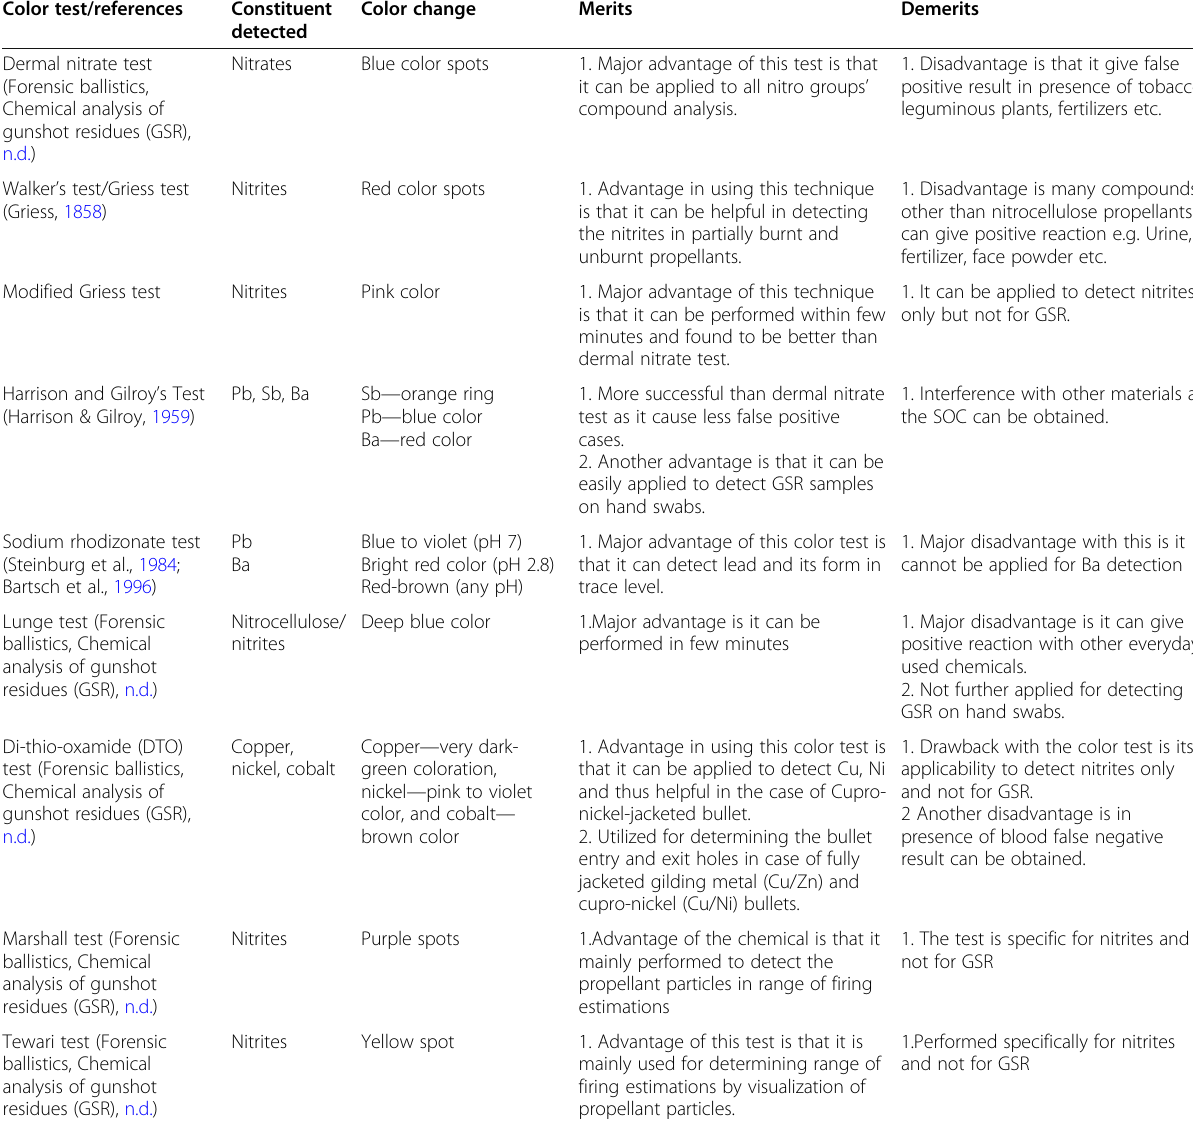
Table 3 Color test performed for the detection of GSR Color